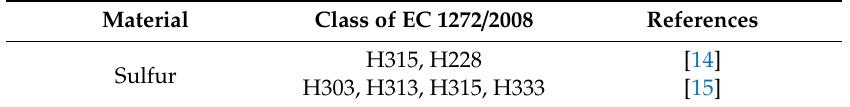
Table 1. Hazard statements related to